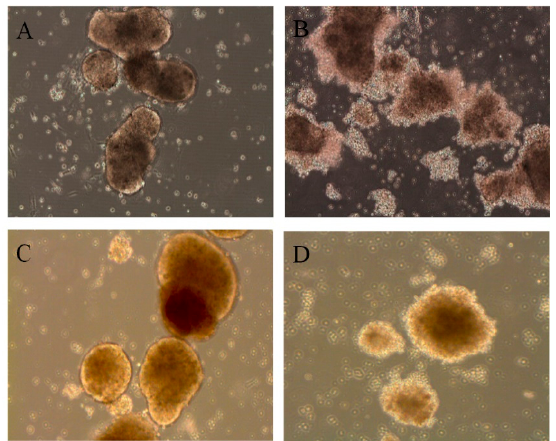
Figure 2. Virus ‐ induced cytopathic effect in explanted human pancreatic exocrine cells and islets three